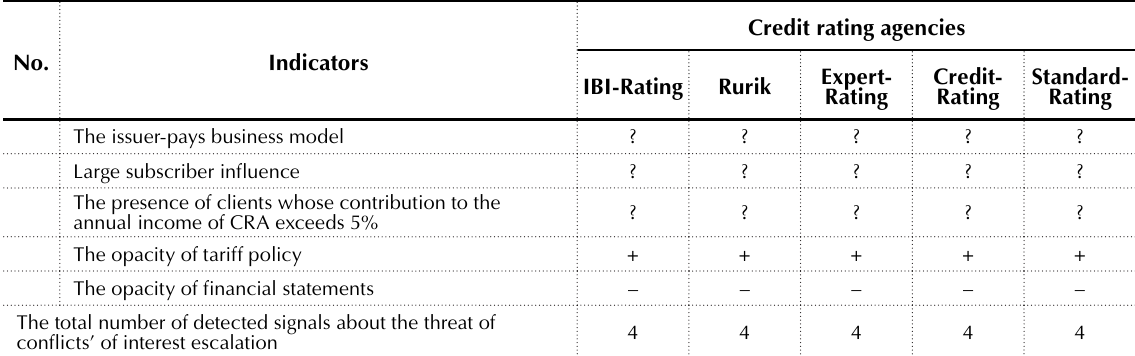
Table 3. The warning signals concerning the potential of conflicts of interest in models of financial activities of CRAs in